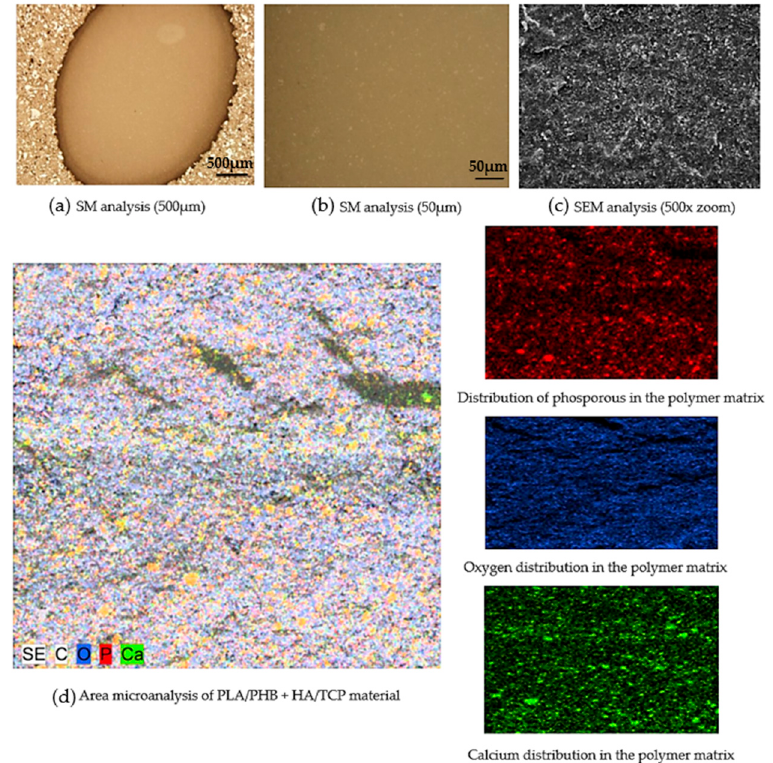
Figure 8. Microscopic analysis of composite biopolymer PLA/PHB + HA/TCP. ( a ) SM analysis (500 μ m); ( b ) SM analysis (50 μ m); ( c ) SEM analysis (500× zoom); ( d ) Area microanalysis of PLA/PHB + HA/TCP material